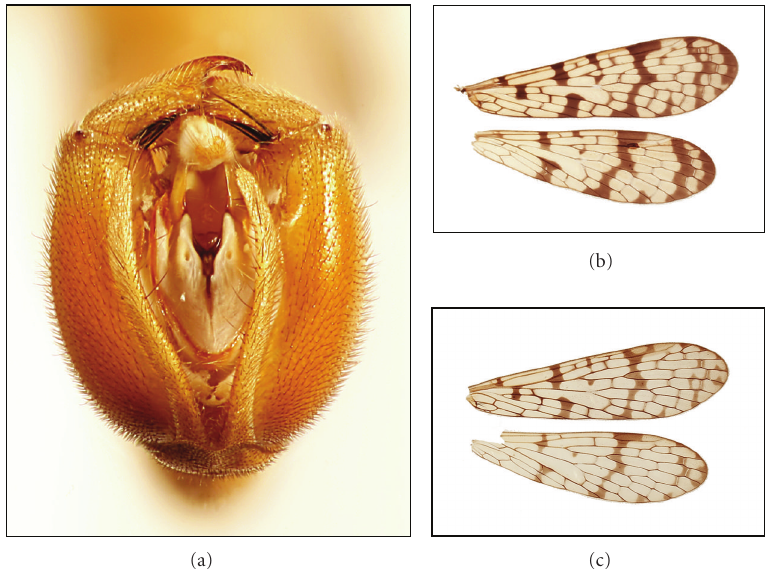
Figure 2: (a) Male genital bulb from Angelina Co. specimen demonstrating well preserved soft tissues, which appear white. The pores situated near the apices of the ventral valves can be seen clearly. (b)-(c) Wings of specimens of Panorpa vernalis from two counties in Texas displaying di ff erences in expression of wing banding. (b) Specimen from Wood Co. (c) Specimen from Angelina